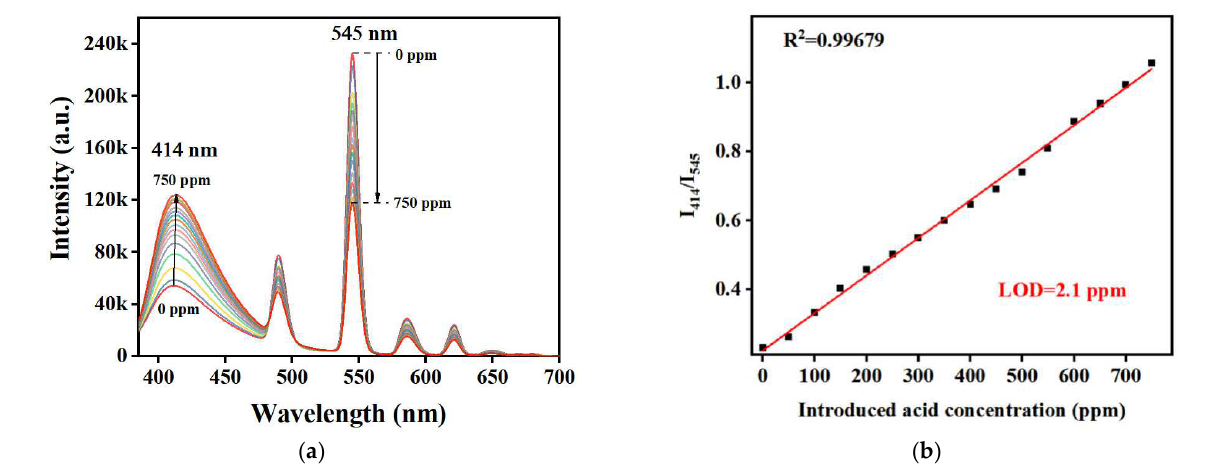
Figure 5. ( a ) Fluorescence spectra of TH25 with an increase in the concentration of FA ( λ ex = 365 nm); ( b ) Fluorescence ratio of TH25 (measured at 414 nm and 545 nm) is fitted to the linear relationship of FA concentration. Table 1. Comparison between TH25 and Reported Methods for Detecting FA.